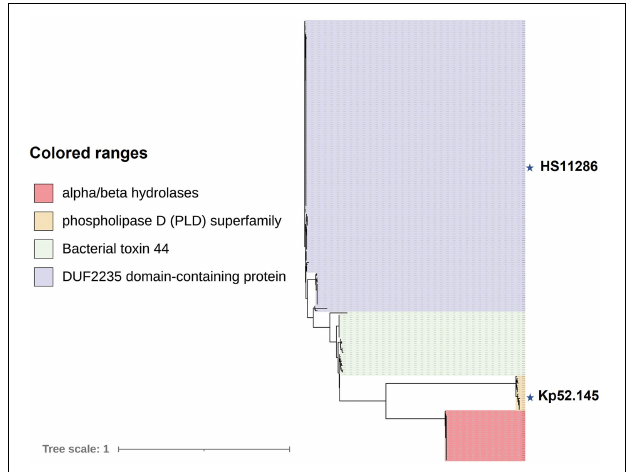
FIGURE 7 | VgrG proteins of K. pneumoniae are separated into distinct phylogenetic classes. An ML phylogenetic tree was generated from 201 aligned VgrG protein sequences. Blocks of the same color indicate that those effector proteins encoded downstream of vgrG have similar functions. Effectors downstream of vgrG with an alpha/beta hydrolase domain are indicated in red, phospholipase D (PLD) superfamily, DUF2235 domain-containing protein, and bacterial toxin 44 effector proteins predicted downstream of vgrG are indicated in yellow, purple, and green, respectively. The labeled stars indicate the listed strains.